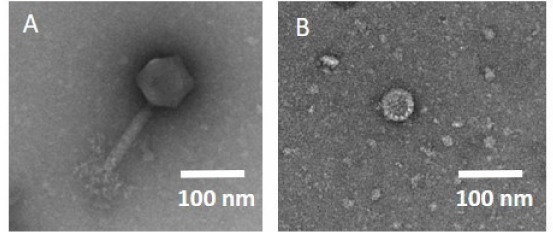
Figure 2. TEM image of the phages produced in the cell-free extract system. ( A ) Phage vB_EcM_muc122-IMB, host E. coli , myovirus, genome size 166.6 kb. ( B ) Phage vB_KoP_muc139-IMB, host K. oxytoca , family Autographiviridae , genome size 43.4